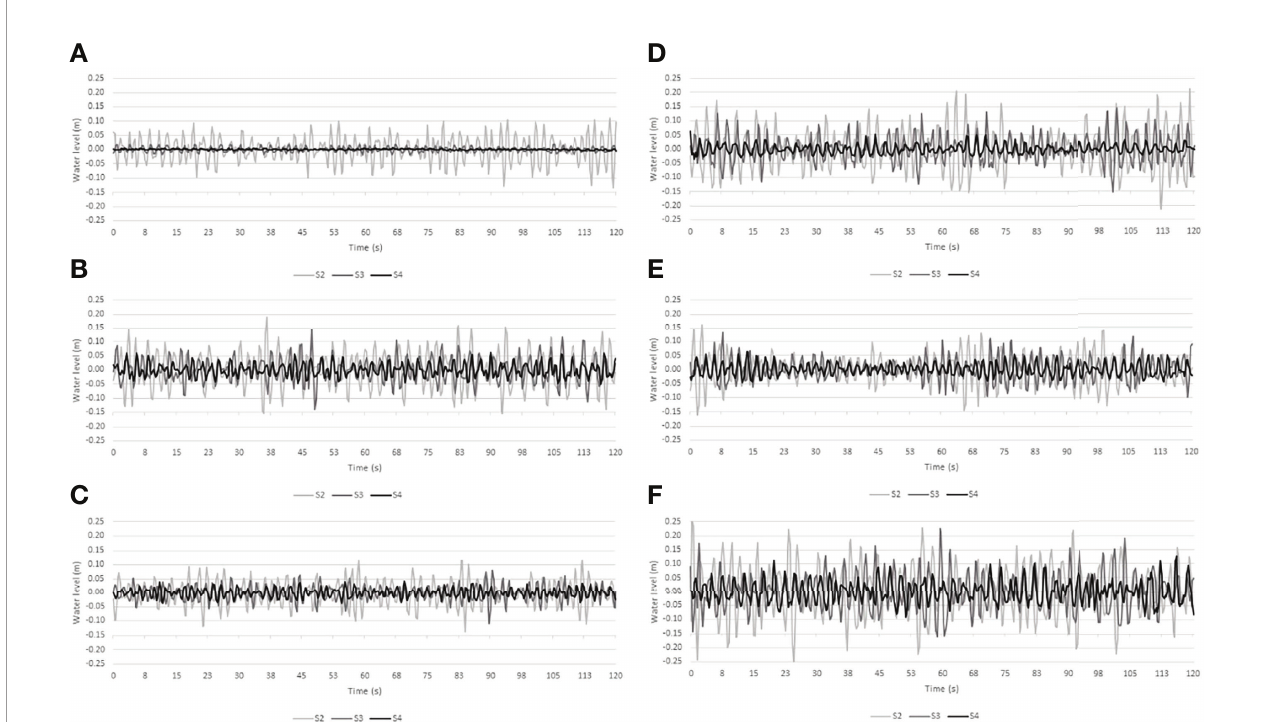
FIGURE 9 | The fi rst 2 minutes of water level fl uctuations at all three transect locations (S2, S3 and S4) as reconstructed from depth-adjusted wave spectra at Histria (A – C) and Cape Dolosman (D – F) for the most energetic incident wave conditions (see Table 2 for dates and further